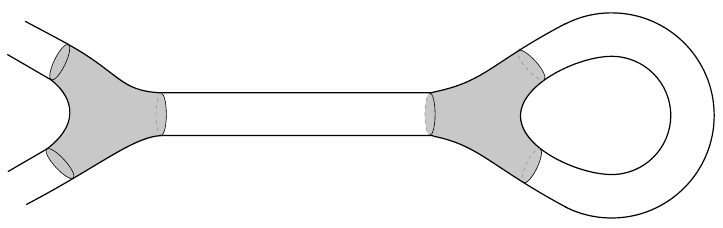
Figure 7 . A Feynman diagram gives Riemann surfaces with metrics that are hyperbolic on the string vertices (shown shaded) and flat on the